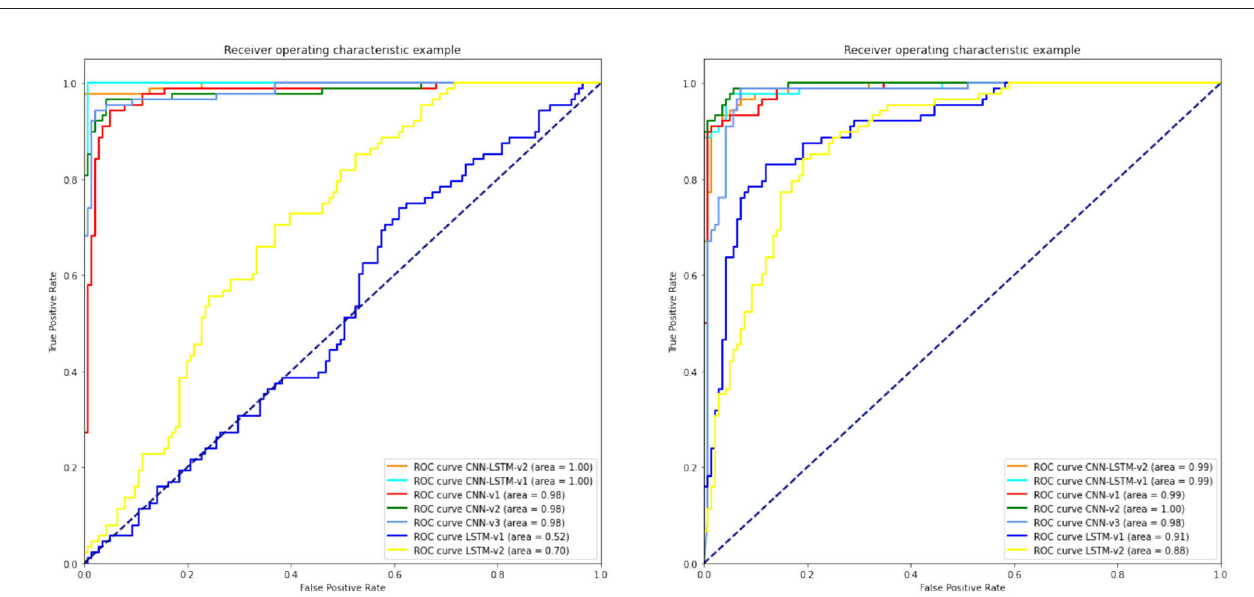
FIGURE 6 | ROC curves of DL methods with ReLU activation function and z -score + L2 normalization. DL, deep learning; ROC, receiver operating characteristic.